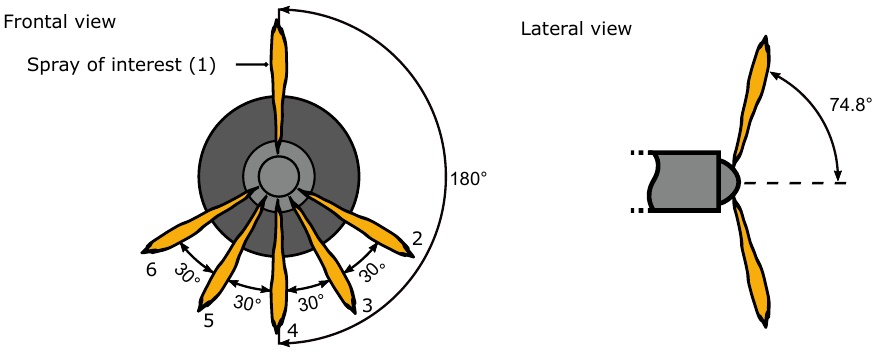
Figure 2. Nozzle configuration of the PCR5 injector.